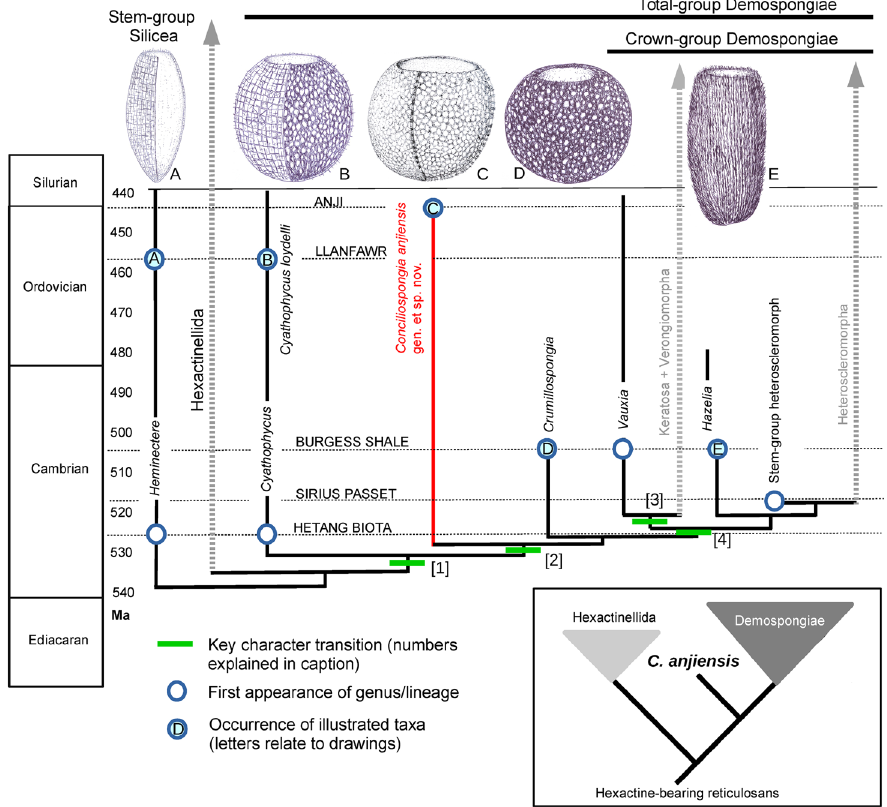
Figure 3. Summary of early demosponge evolution. Schematic diagram showing the phylogeny and stratigraphic distribution of the stem and basal crown groups of Demospongiae, including key fossil taxa and their occurrences. The inset summary shows the simplified position of Conciliospongia anjiensis gen. et sp. nov. relative to the extant silicean classes. Phylogenetic topology of extant taxa (thick dashed lines) conforms with molecular interpretations 8 . Primary hypothesis of fossil relationships are based on ref. 12 for vauxiid and hazeliid relationships and ref. 28 for Cyathophycus loydelli . Stem-group heteroscleromorph refers to ref. 20. The key skeletal transitions are the origination of a monaxon-based inner skeletal layer in Cyathophycus [1], subsequent loss of hexactines in the stem lineage of demosponges [2], and ultimately also the loss of monaxons within the Vauxiidae (leading to Keratosa and Verongiomorpha) [3]; the loss of a simple globose body form (and concomitant change in growth patterns) accompanied the origin of crown-group demosponges [4]. Cambrian occurrences of Heminectere (listed as Protospongia cf. conica ) and Cyathophycus (described as Diagoniella cyathiformis ) are after ref. 41, Ordovician occurrences of Heminectere and Cyathophycus are from ref. 33, and first appearances of Crumillospongia , Vauxia and Hazelia are from ref.